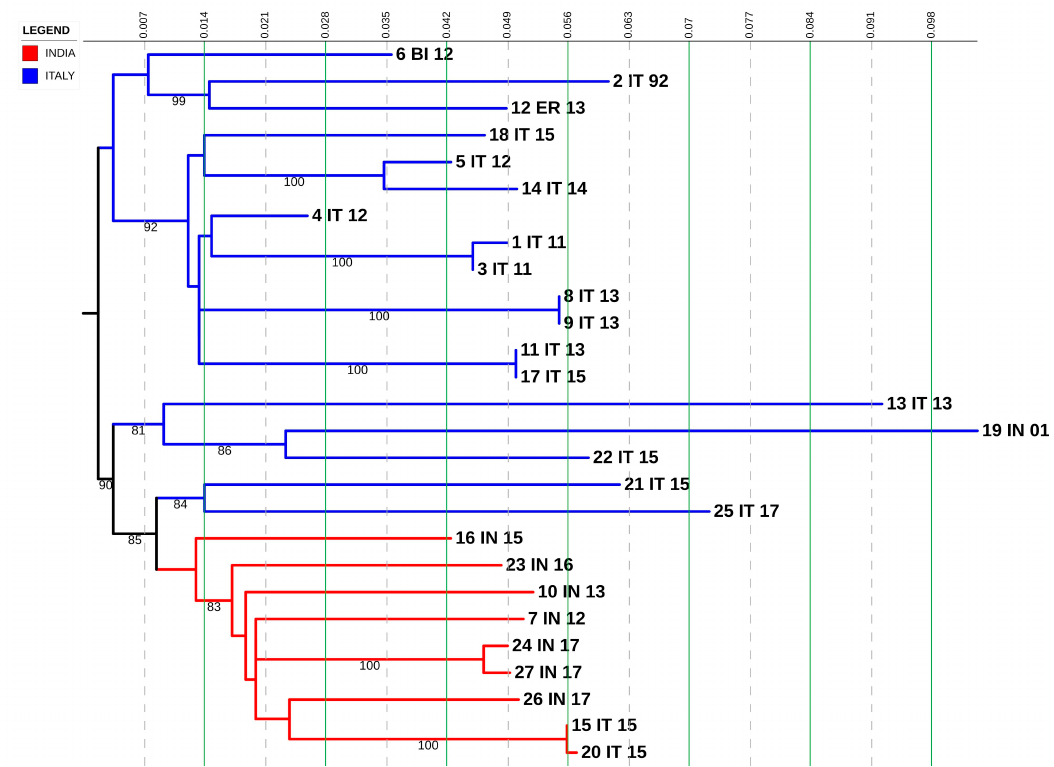
Figure 6. Phylogenetic inference derived from sequence analysis of the subtype C. Maximum likelihood phylogenetic tree built using the iq-tree software and displayed via i-Tol. The substitution model used is GTR + G + I, with 1000 replicates in bootstrap analysis. Branch support values are shown for each tree, consisting of related bootstrap proportions. Compressed clades represent the control group for correct phylogeny inference.